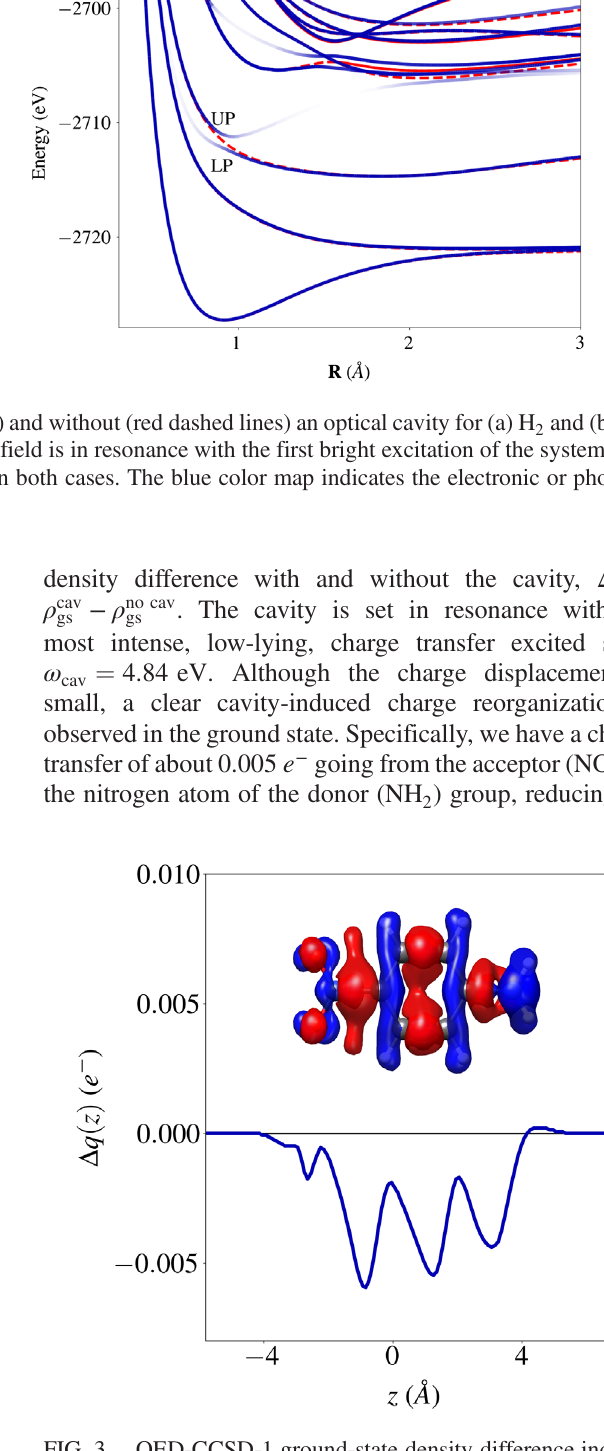
4 . 84 eV) and cav ¼